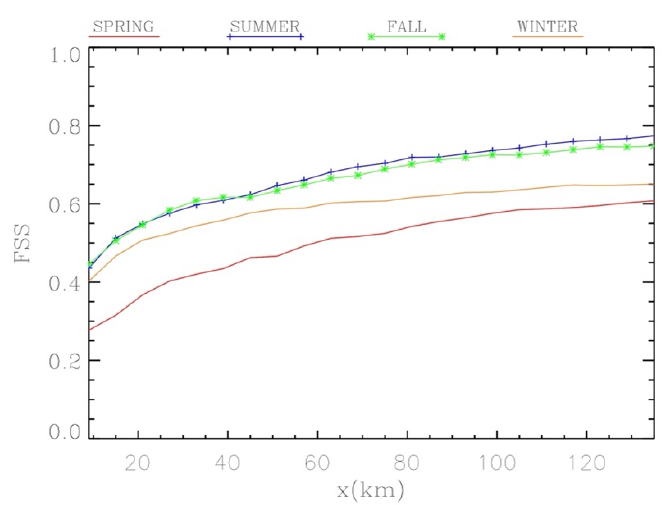
Figure 7. Fraction skill score for different scales for x from 9 to 129 km in 6 km increments. The FSS refers to the L75 configuration and the event forecast is 1 stroke per grid cell.